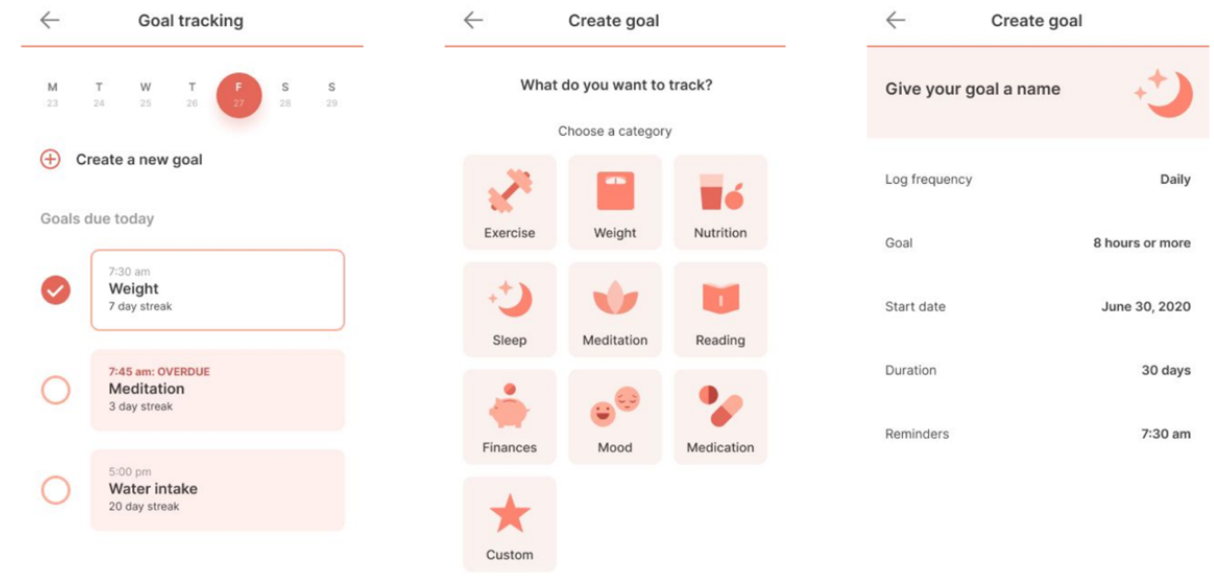
Figure 6. Goal tracking in